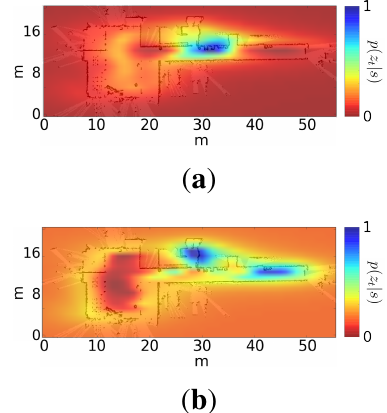
Figure 5. Likelihood distribution provided by the wireless observation model at two different positions (highest values in blue; lowest values in